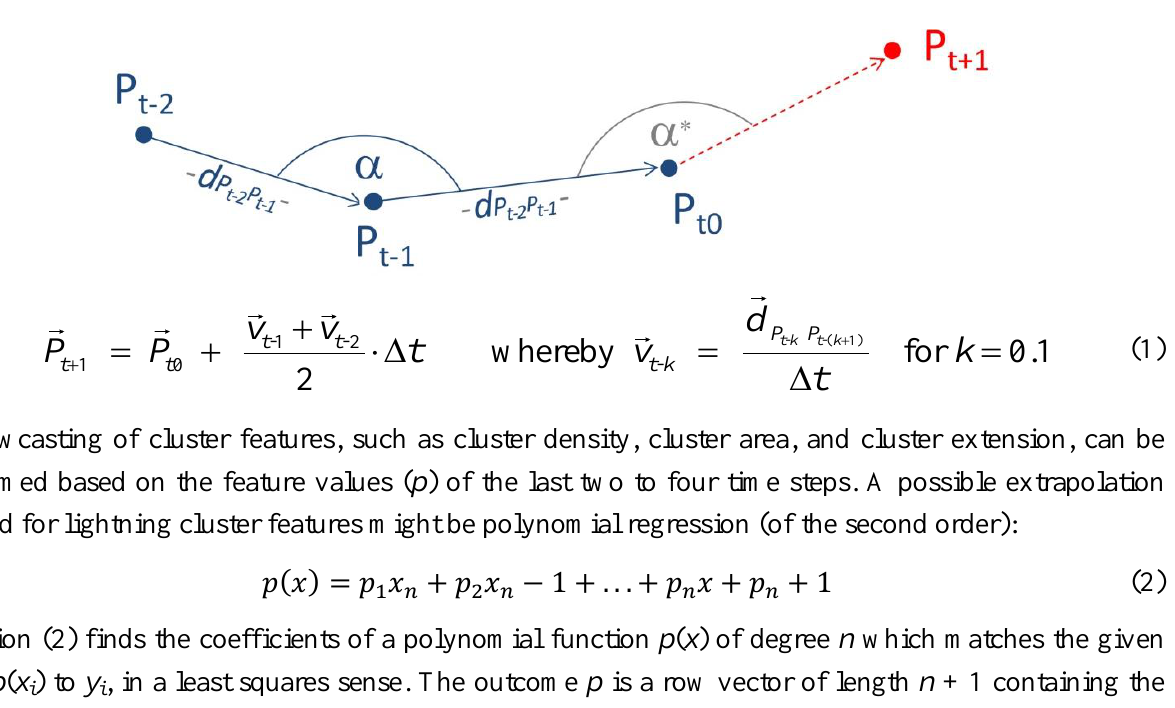
Figure 4. Cluster centroid nowcasting concept (2D